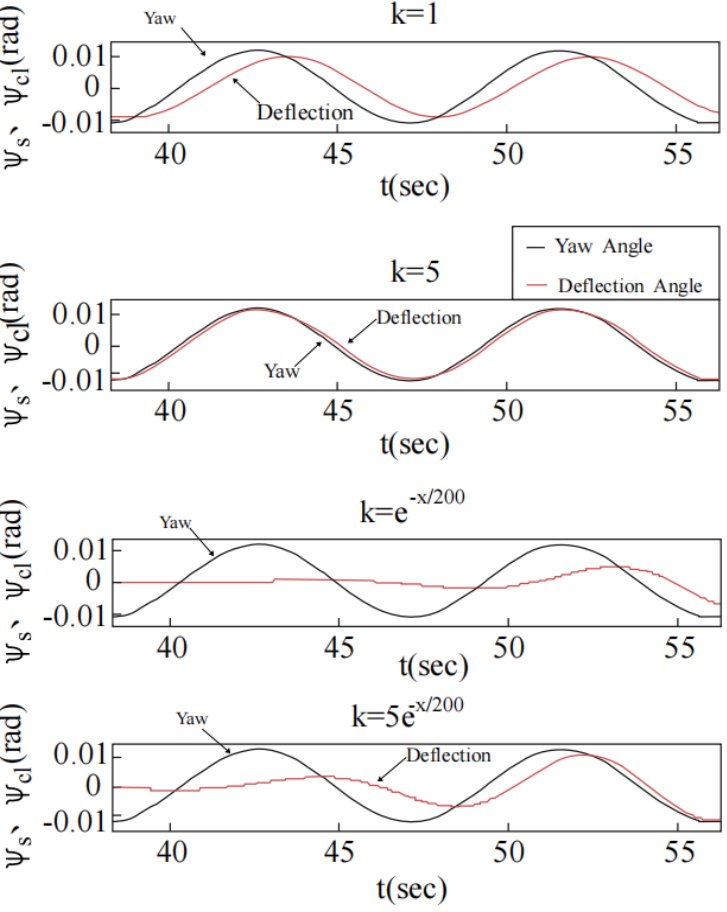
Figure 25. Measuring axis tracking response curves under integral tracking strategies with different k .